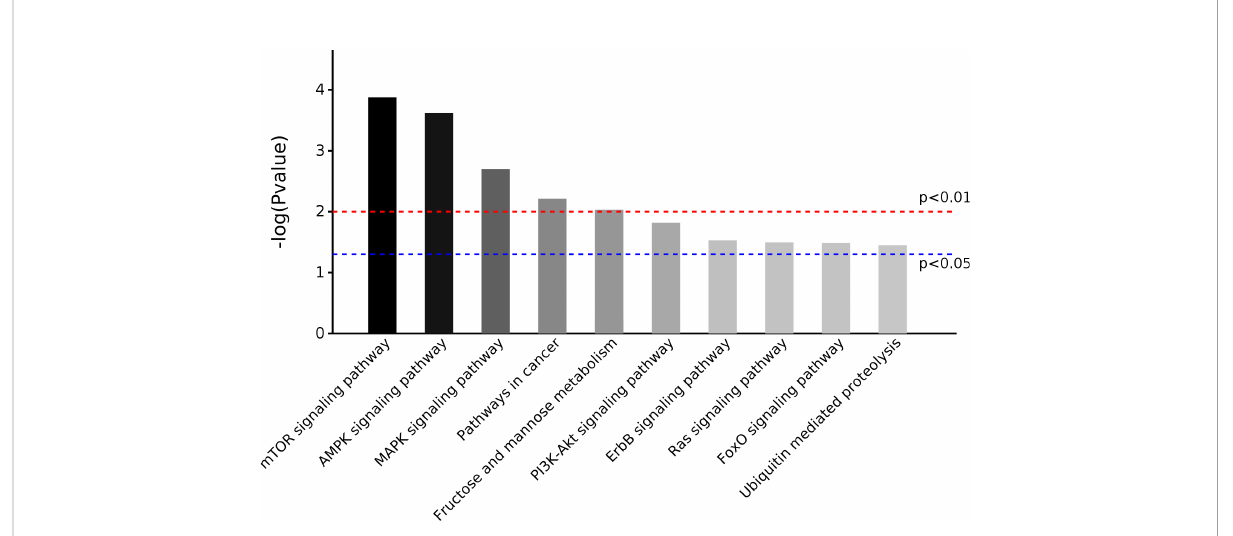
FIGURE 5 KEGG pathway analysis for predicted target genes of four candidate miRNAs.